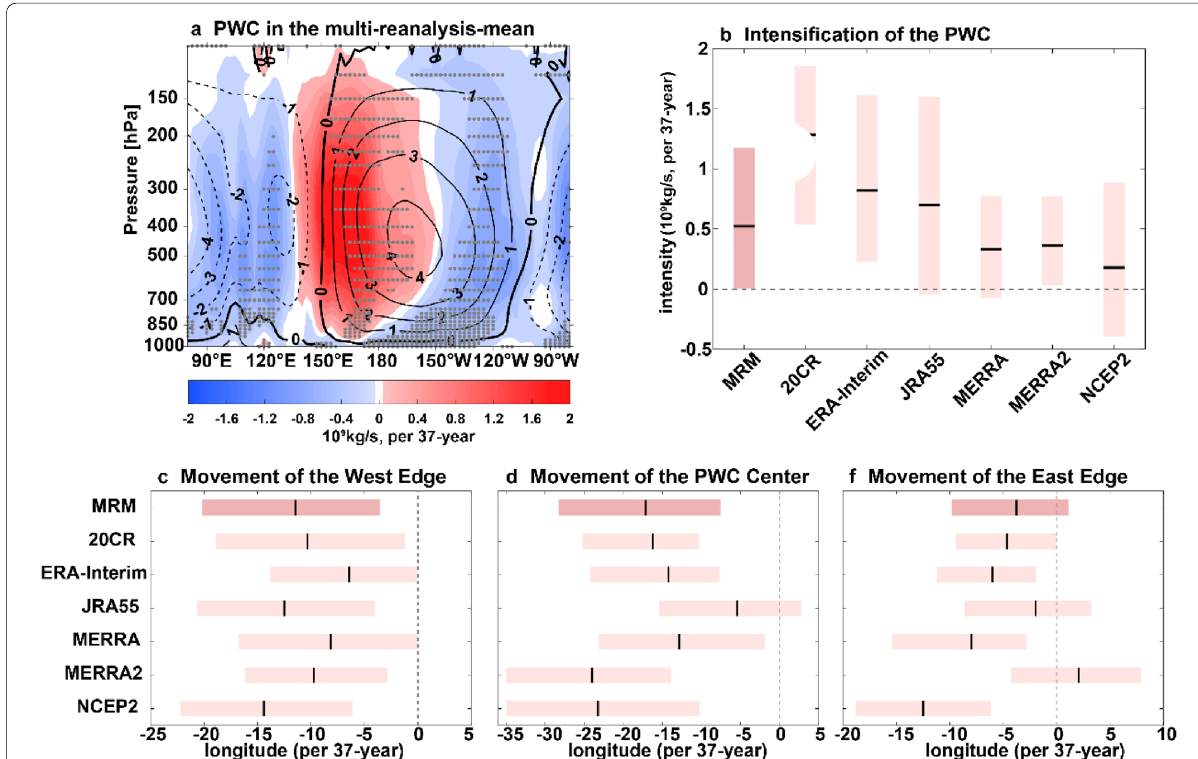
Fig. 1 The changes of the Pacific Walker circulation (PWC) in reanalysis datasets. a Shows the climatology (contours) and the trend (color shading) of the PWC from 1979 to 2015 in the ensemble‑mean of six reanalysis datasets. The gray dots represent the areas with confidence level of 95%. b Quantifies the total trend (change in 37 years from 1979 to 2015) of the PWC in the multi‑reanalysis‑mean (MRM) and each of the six reanalyses, with black bars showing the amplitude of the trend and the error bars indicating its 95% confidence intervals. c – e Quantify the westward shifts of the west edge ( c ), the center ( d ), and the east edge ( e ) of the